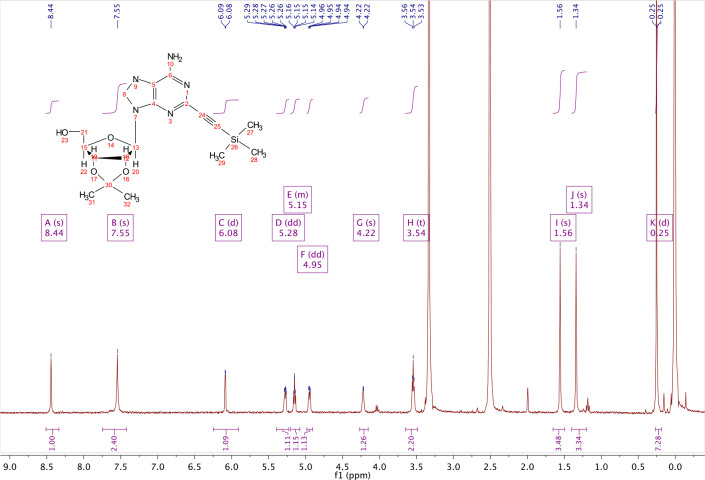
1H NMR of compound 2.